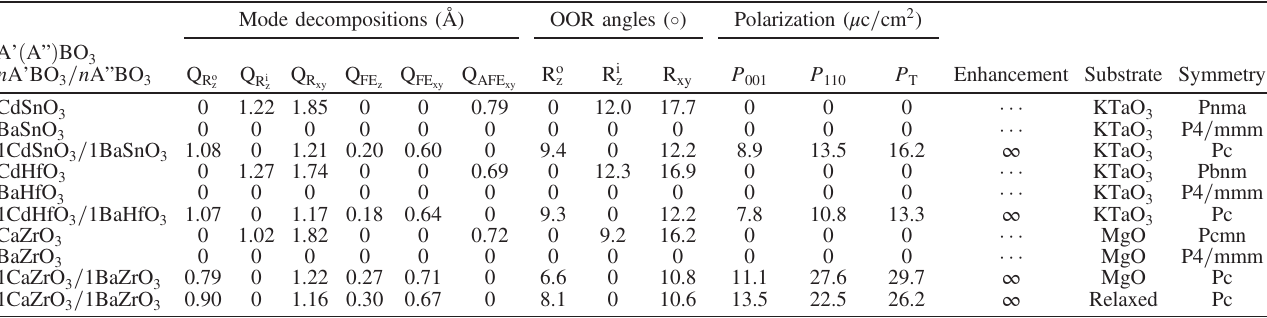
TABLE III. Predicted new artificial ferroelectric materials based on nonpolar perovskites. The columns are as follows. (1) Mode as out-of-phase OOR around [001], Q as in-phase OOR around [001], Q as OOR around [110], Q as decompositions (Å) of Q R o z R xy FE z R i z as polar distortion along [110], and Q as in-plane antipolar distortion. Their symmetries are polar distortion along [001], Q FE xy AFE xy , R i , R for out-of-phase OOR around [001], in-phase OOR labeled as M − 1 , M þ 3 , M − 5 , Γ − 3 , Γ − 5 , respectively. (2) OOR angles (degrees) R o xy z z around [001], and OOR around [110] (octahedron tilt), respectively. (3) The polarizations ( μ c = cm 2 ) along the [001] direction P 001 and along the [110] direction P 110 , and the total polarization P . (4) The polarization enhancement. (5) Substrate for the epitaxial growth of T the superlattices, KTaO 3 ð a ¼ 3 . 99 Å Þ and MgO ð a ¼ 4 . 21 Å Þ . (6) Space group symmetry of both the strained bulk and superlattice. Mode decompositions